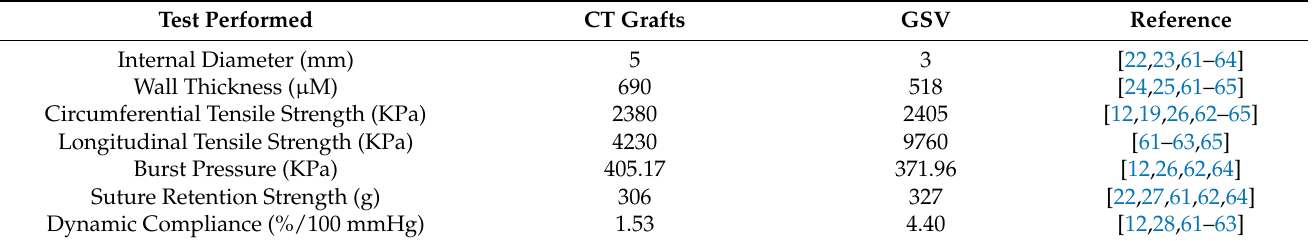
Table 4. Mechanical properties in blood vessels: grafts in clinical trials (CT grafts) and great saphenous vein (GSV).